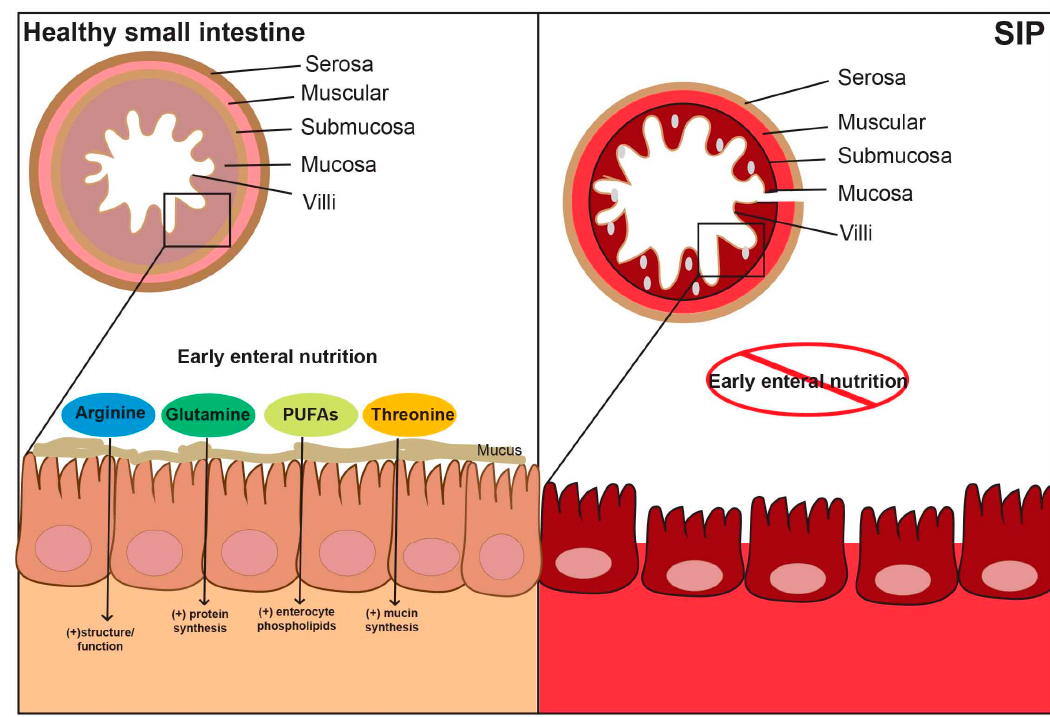
Figure 3. Relationship of early enteral nutrition to SIP. Early enteral nutrition provides arginine, threonine, glutamine and polyunsaturated fats (PUFAs) that result in improved gut structure / function, mucin synthesis and production of enterocyte phospholipids. Delayed enteral nutrition results in increased SIP susceptibility.